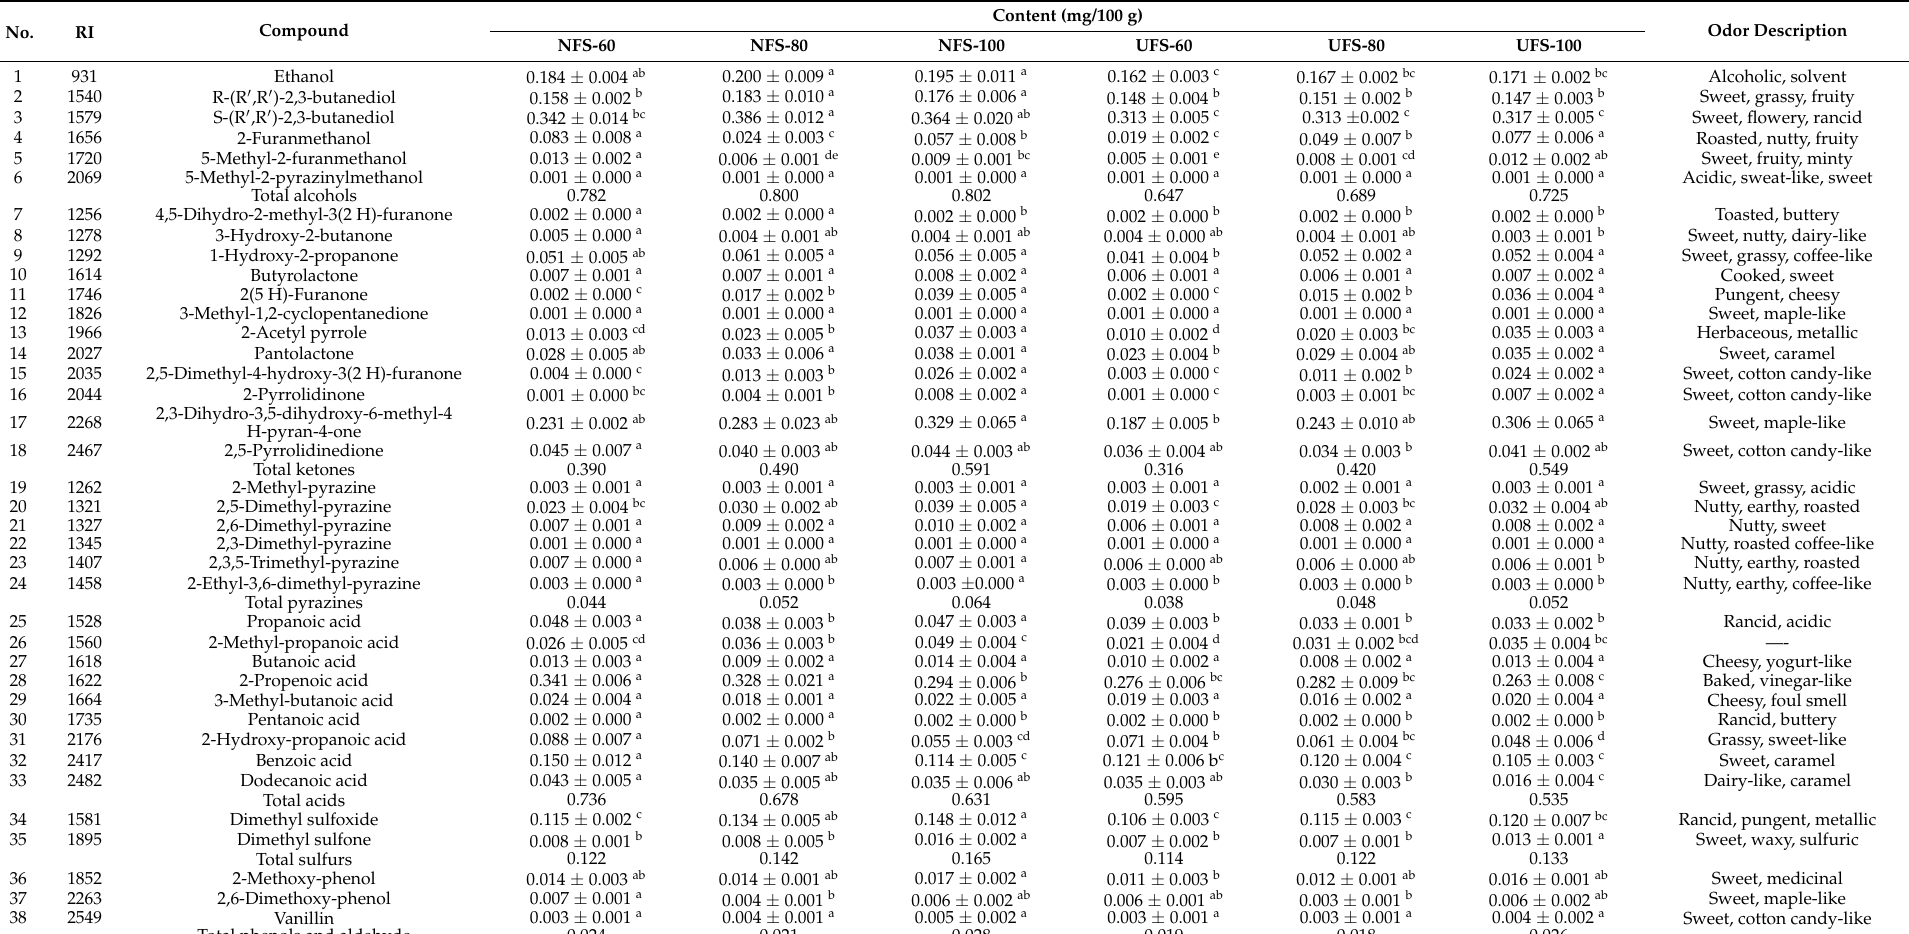
Table 3. Volatile compounds of palmyra palm syrup prepared by thermal and ultrafiltration